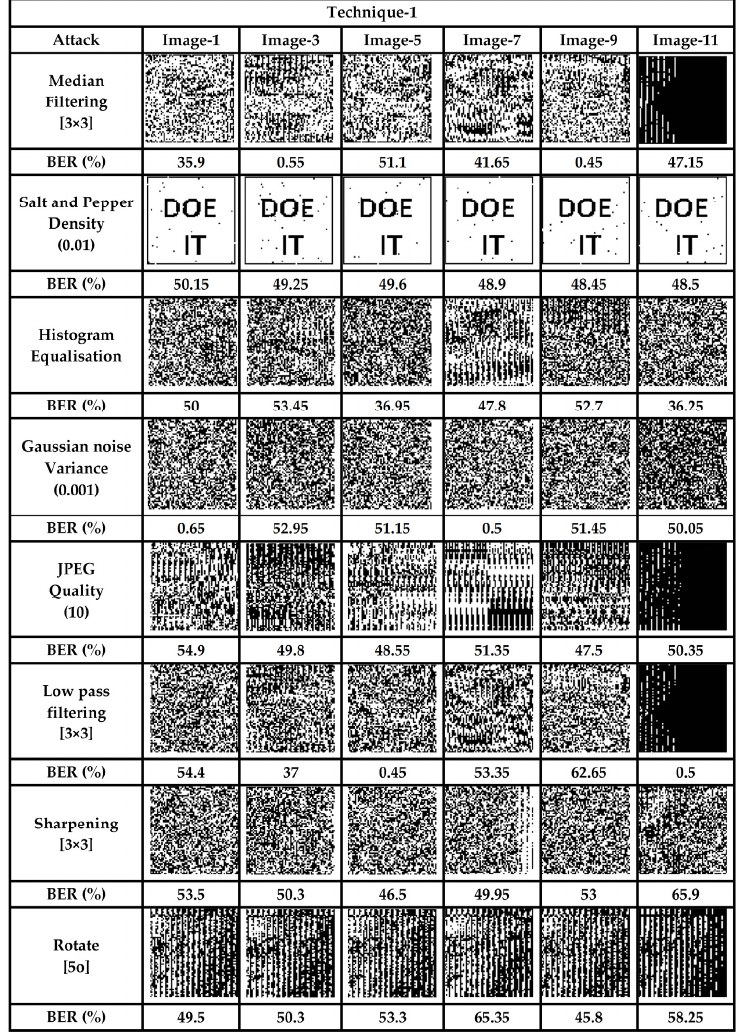
Figure 7. Authentication and fragility analysis (Technique-1).